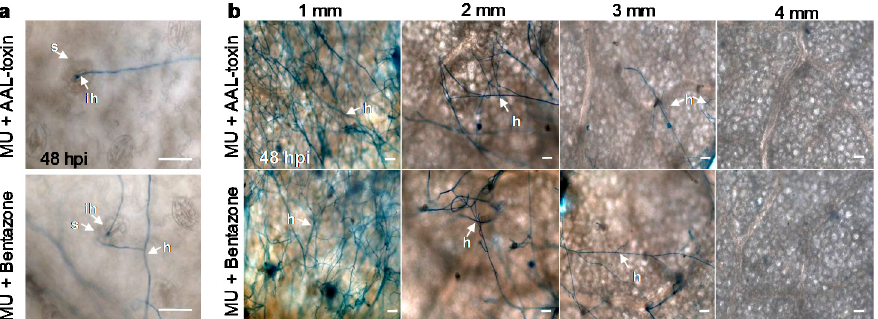
Figure 8. Endogenous AAL-toxin and bentazone increased hyphal penetration and invasive hyphal